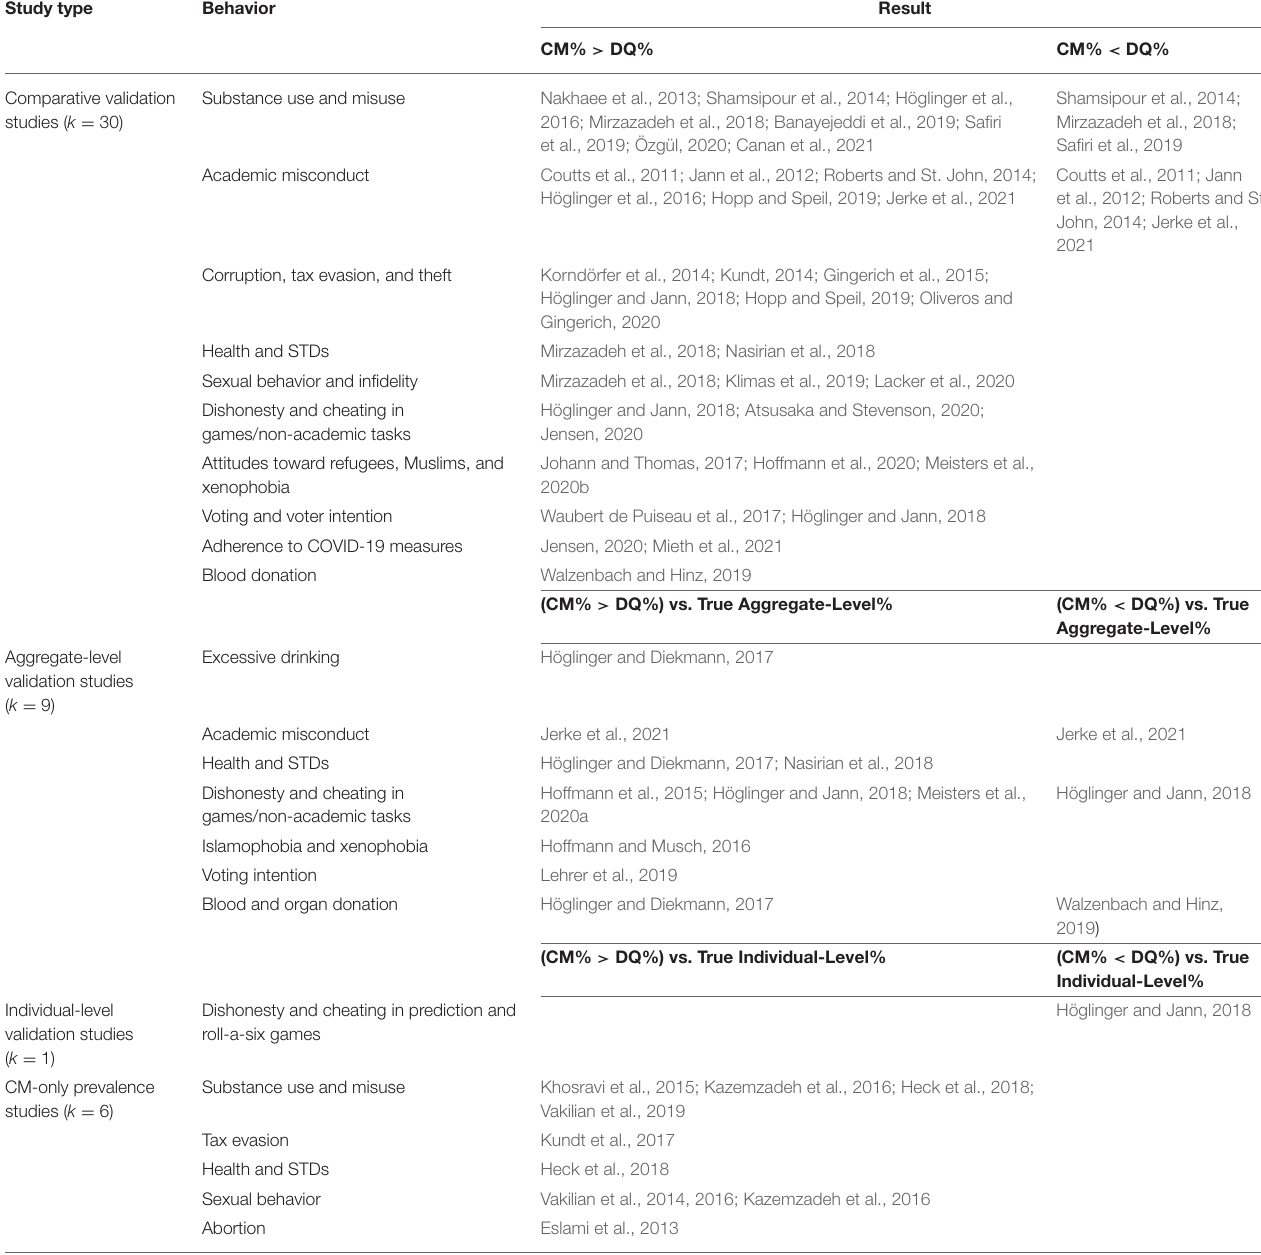
TABLE 1 | Summary of CM study type, sensitive/transgressive behavior investigated and